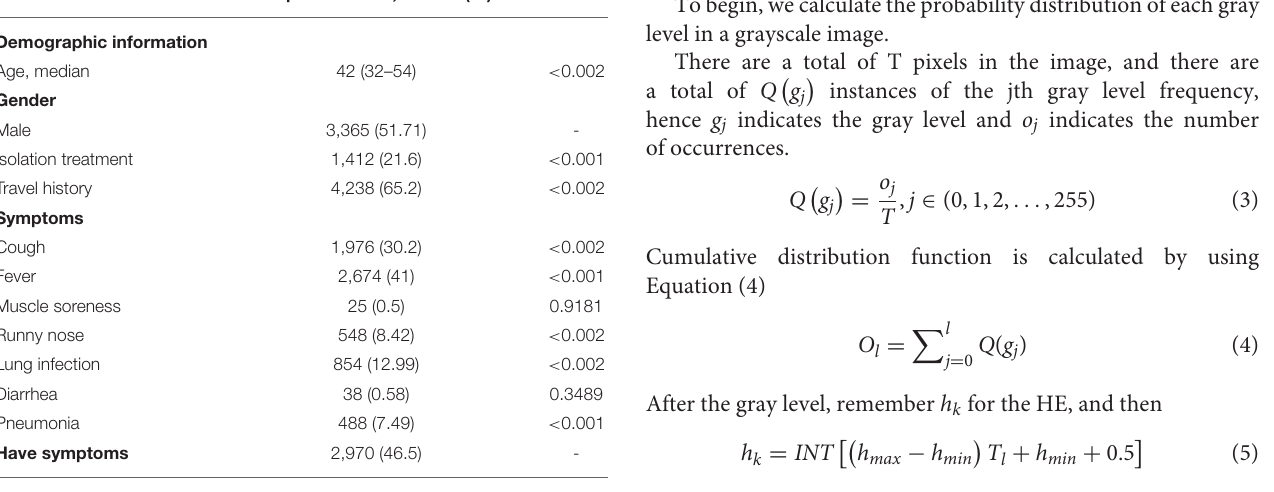
TABLE 1 | Patient characteristics.